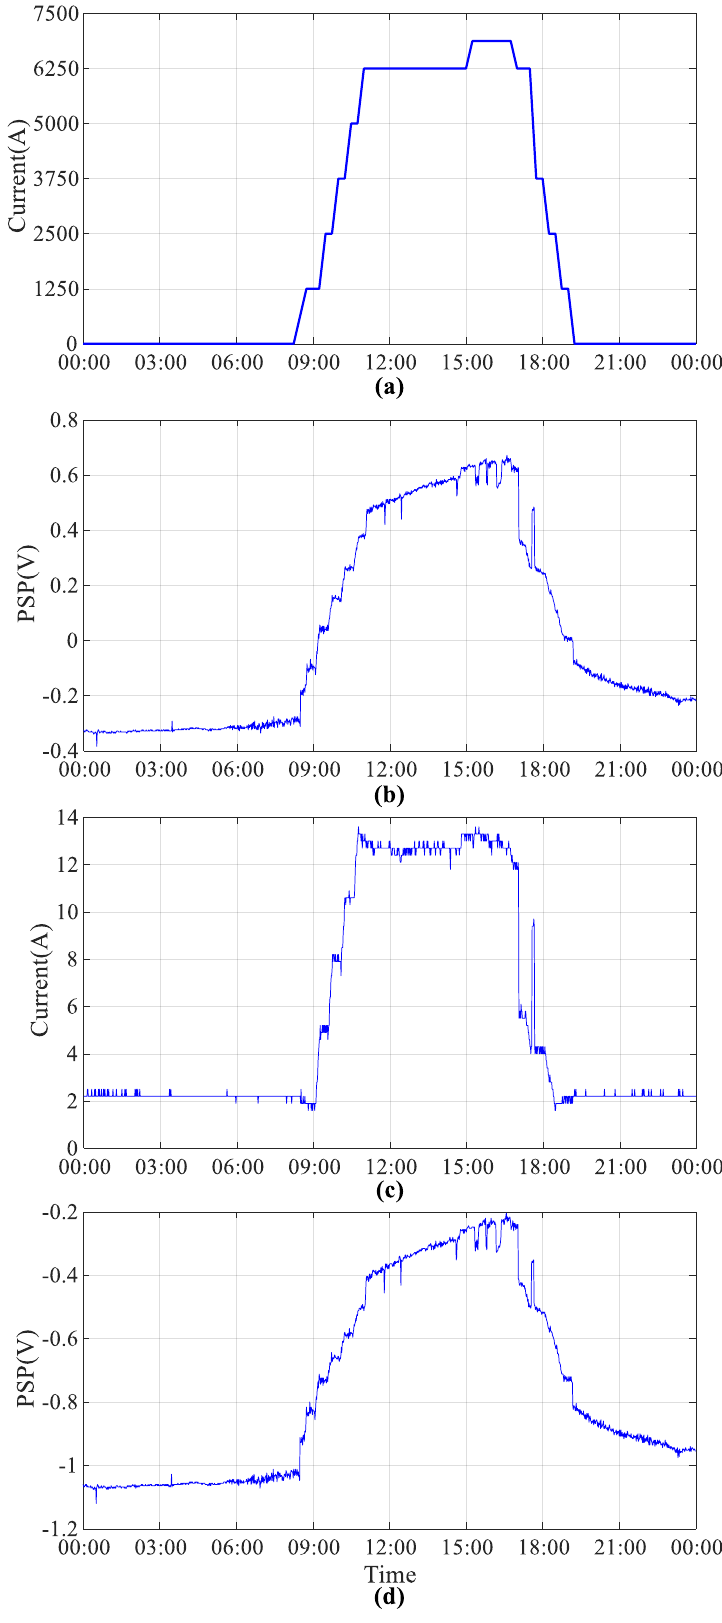
Figure 4. Monitoring data during the commissioning of the Shangshan project on 2 January 2019: ( a ) Grounding current of the Gaoqing electrode; ( b ) PSP of the Xiligu site; ( c ) stray current of the Changyi site; ( d ) PSP of the Changyi site.